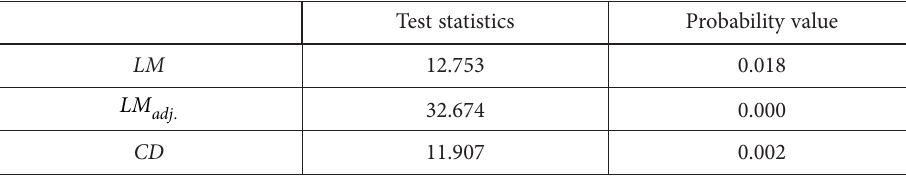
Table 3. Cross-sectional dependence tests (source: own processing)